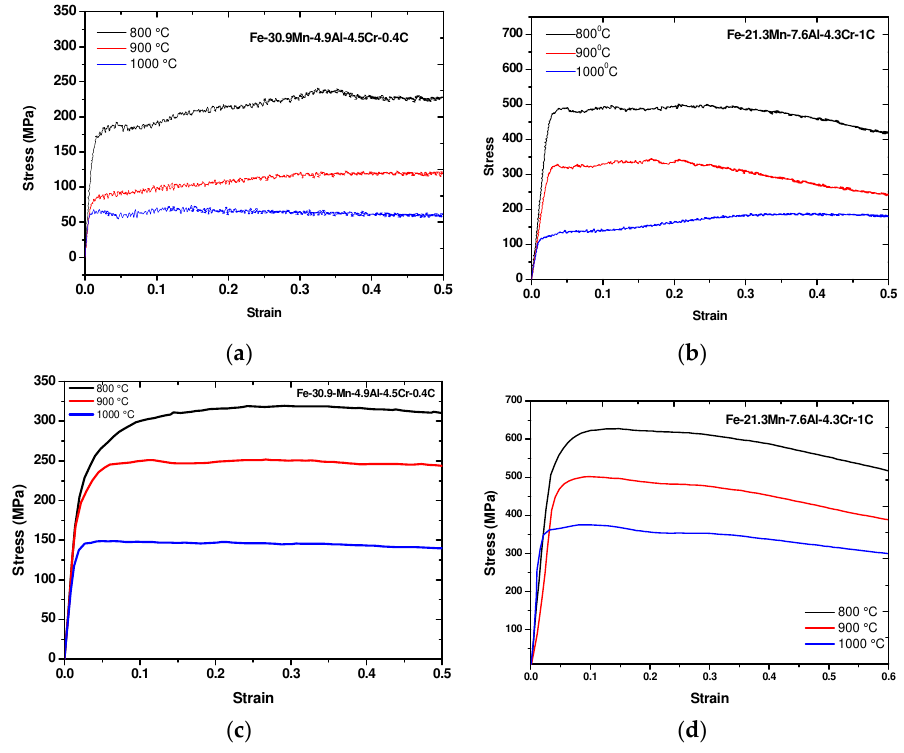
Figure 5. Flow stress at different deformation temperatures for Fe-30.9Mn-4.9Al-4.5Cr-0.4C (Sample A) at ( a ) 0.1 s −1 and ( c ) 5 s 1 ; Fe-21.3Mn-7.6Al-4.3Cr-1C (Sample B) at ( b ) 0.1 s −1 and ( d ) 5 s −1 .